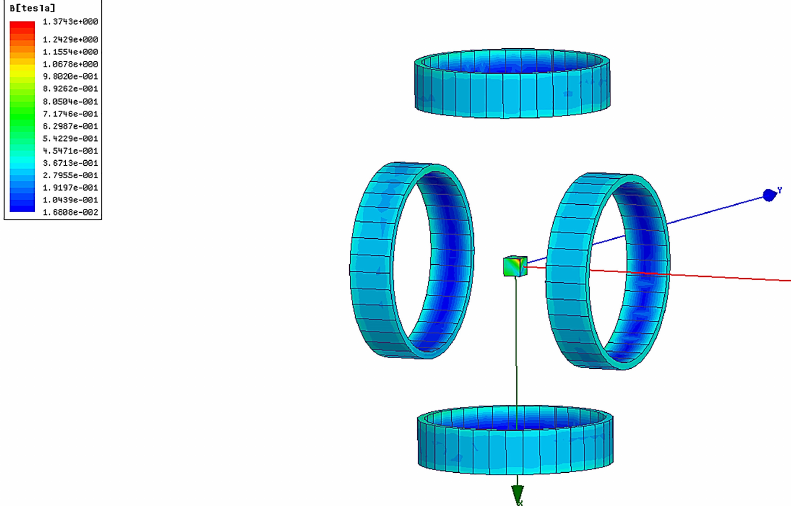
Figure 11. Cloud diagram of the magnetic induction strength of the magnetized drive coil.